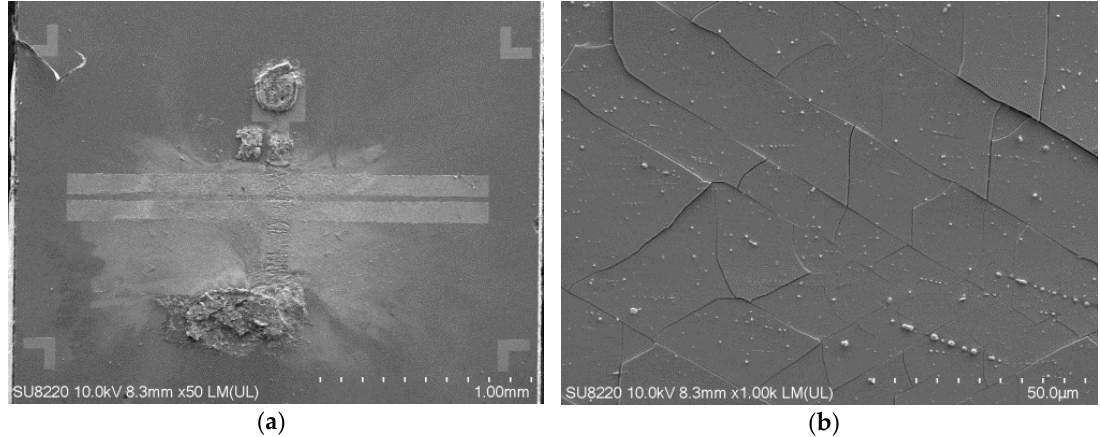
Figure 6. SEM images of the ( a ) breakdown-state MSM varactor and ( b ) GaN epitaxial wafer structure cracked on the